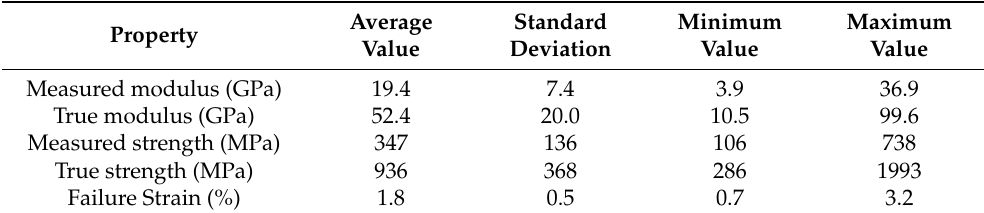
Table 3. Measured and true tensile properties of flax technical fibres.